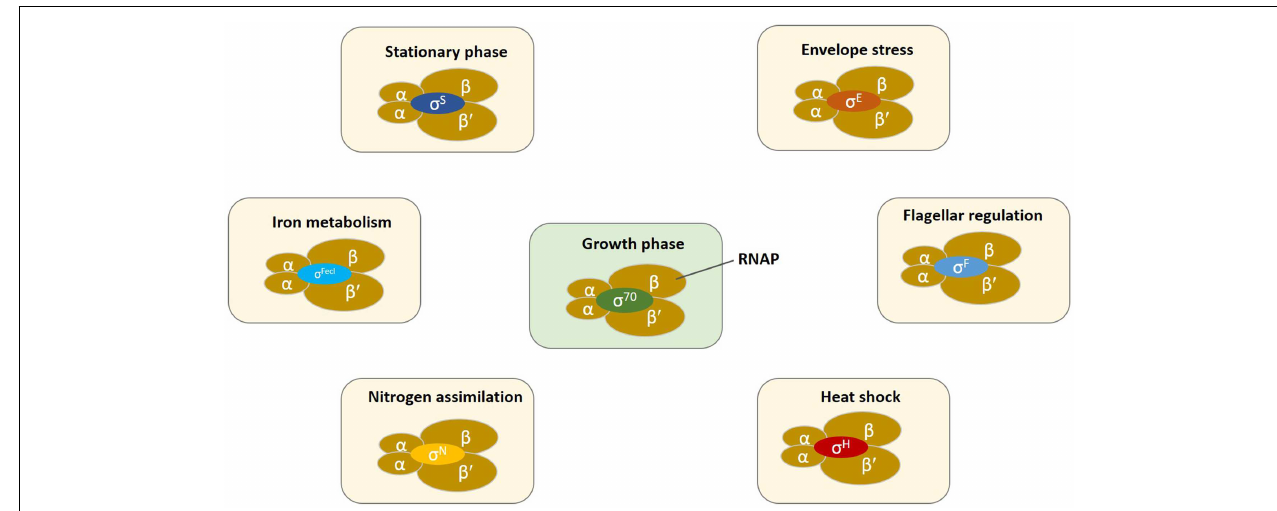
conditions. σ Factors in exponential growing cells, σ 70 / σ D / σ A ; stationary or stress phase, σ S / σ 38 / σ B ; heat shock, σ H / σ 32 ; extracytoplasmic function or extreme heat shock, σ E / σ 24 ; iron metabolism, σ FecI ; nitrogen regulation, σ N / σ 54 ; expression of flagellar genes, σ F / σ 28 .The small subunit ω is omitted for